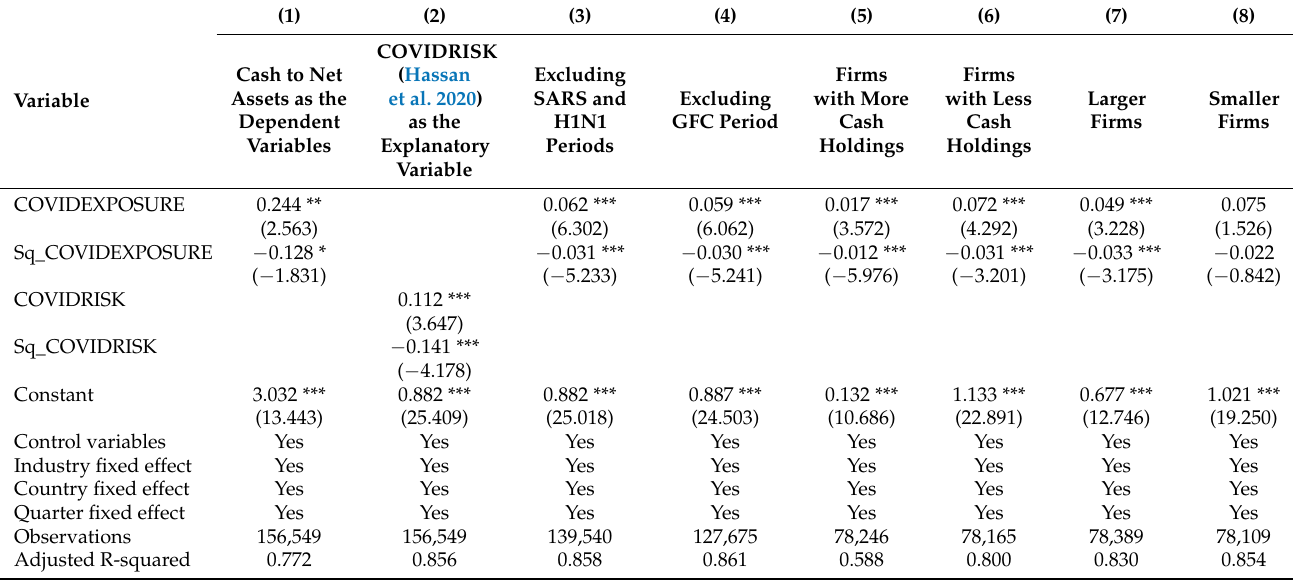
Table 5. Robustness test